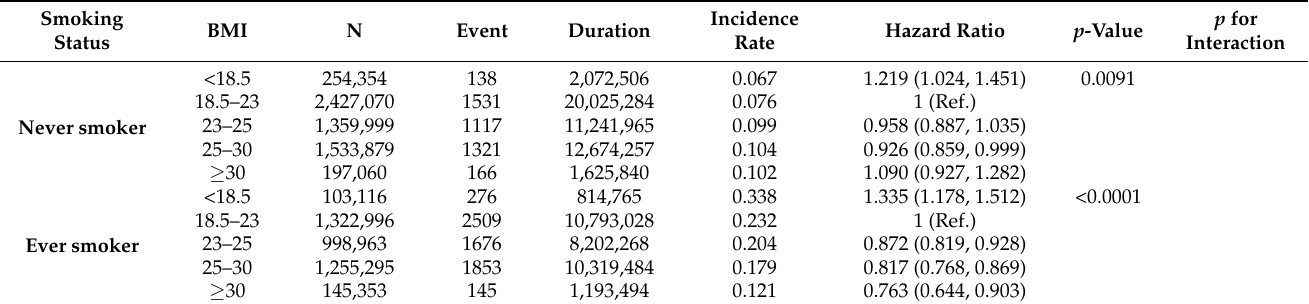
Table 4. Interactions analysis: body mass index with smoking on the occurrence of head and neck cancer.